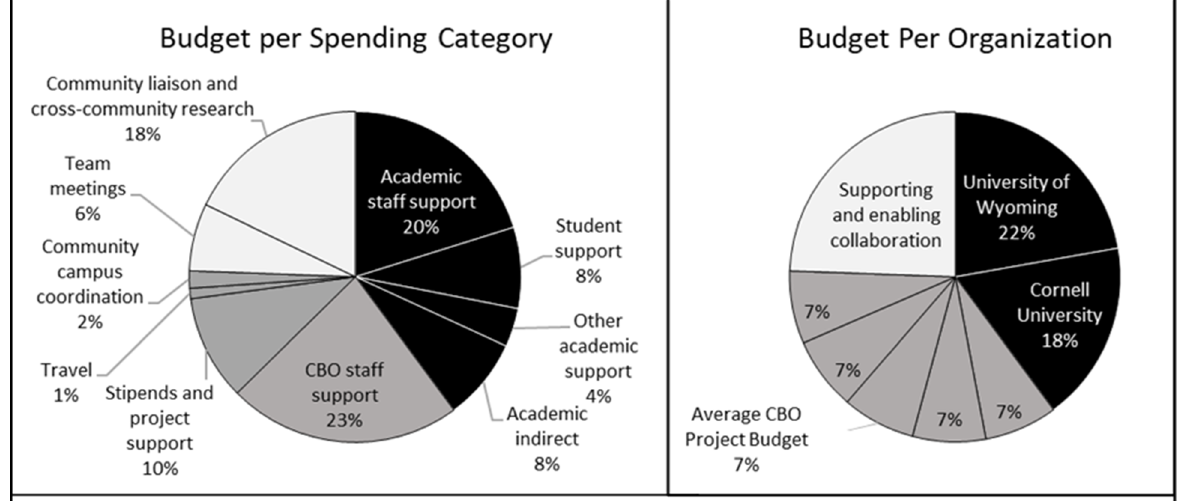
Figure 1: Food Dignity Spending of the US$4,978,700 Budget, by Category,